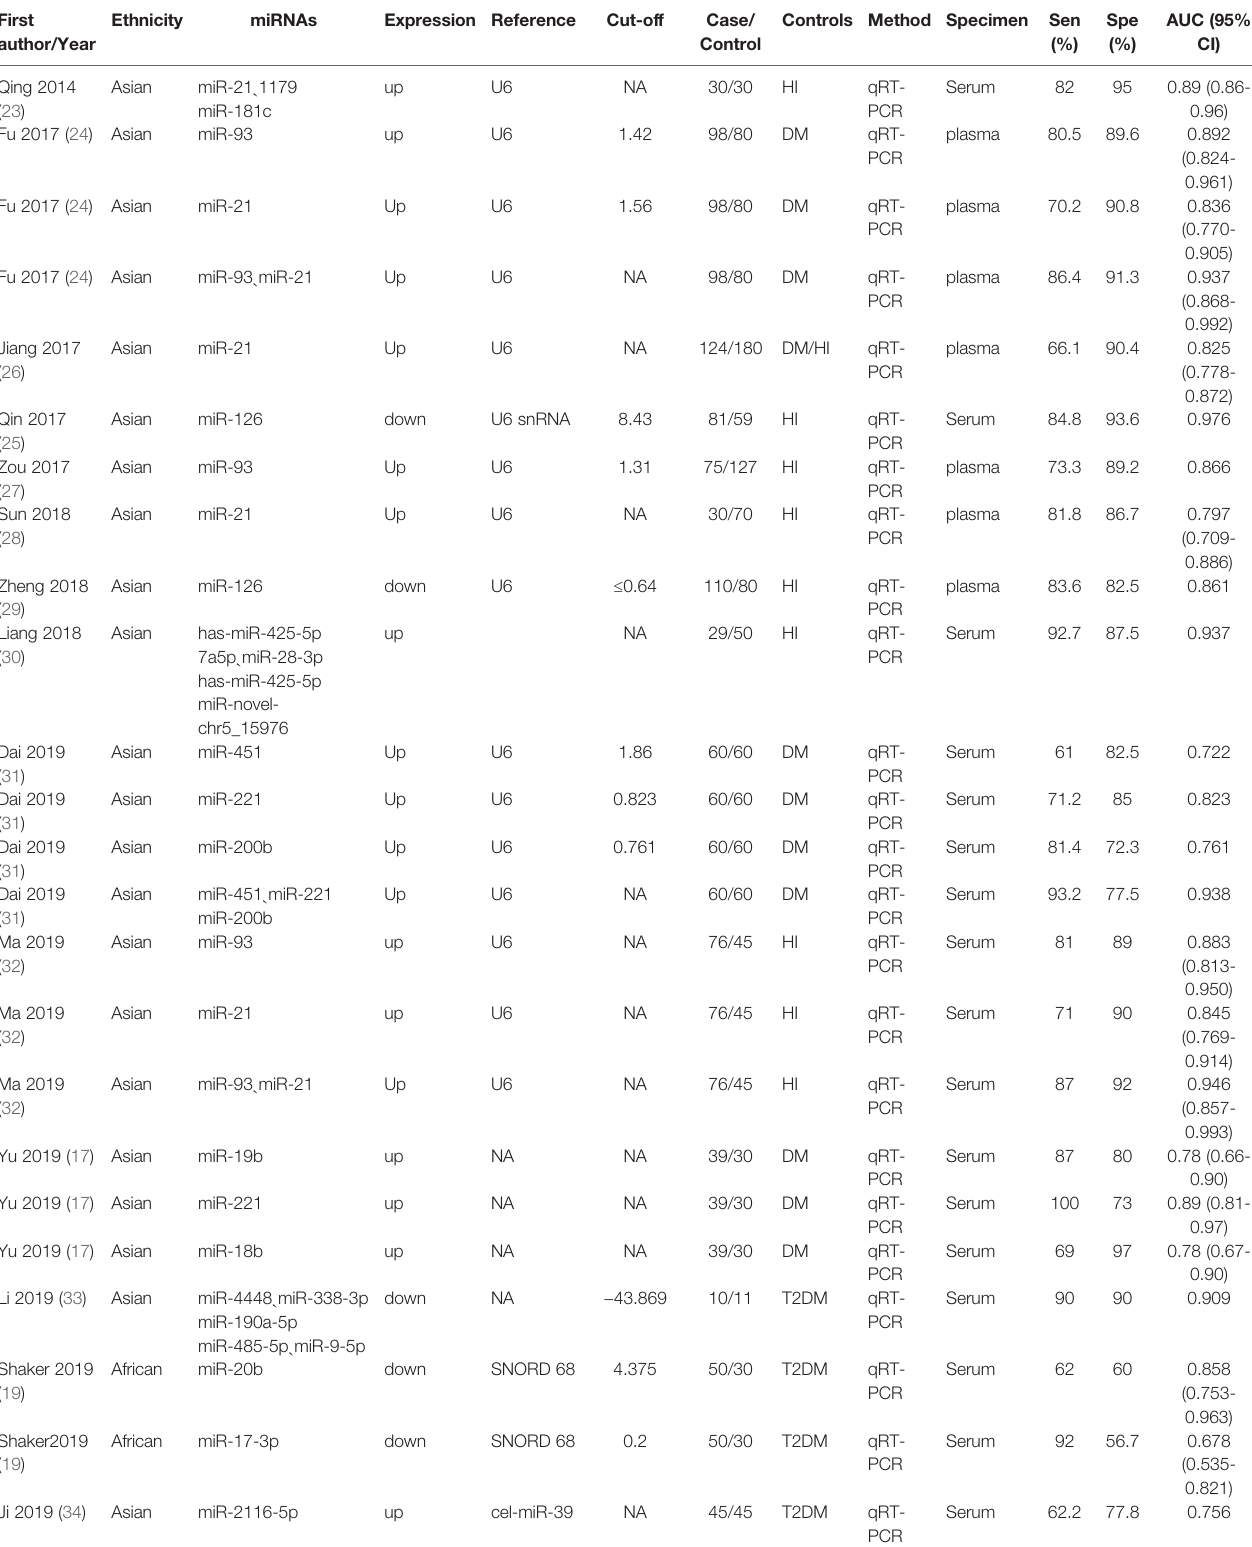
TABLE 1 | Characteristics of the included